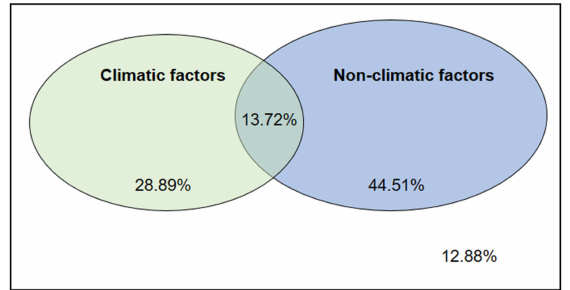
Figure 5. Venn diagram showing the contributions of climatic and non-climatic factors to plant altitudinal distribution in the central Taihang Mountain region, northern